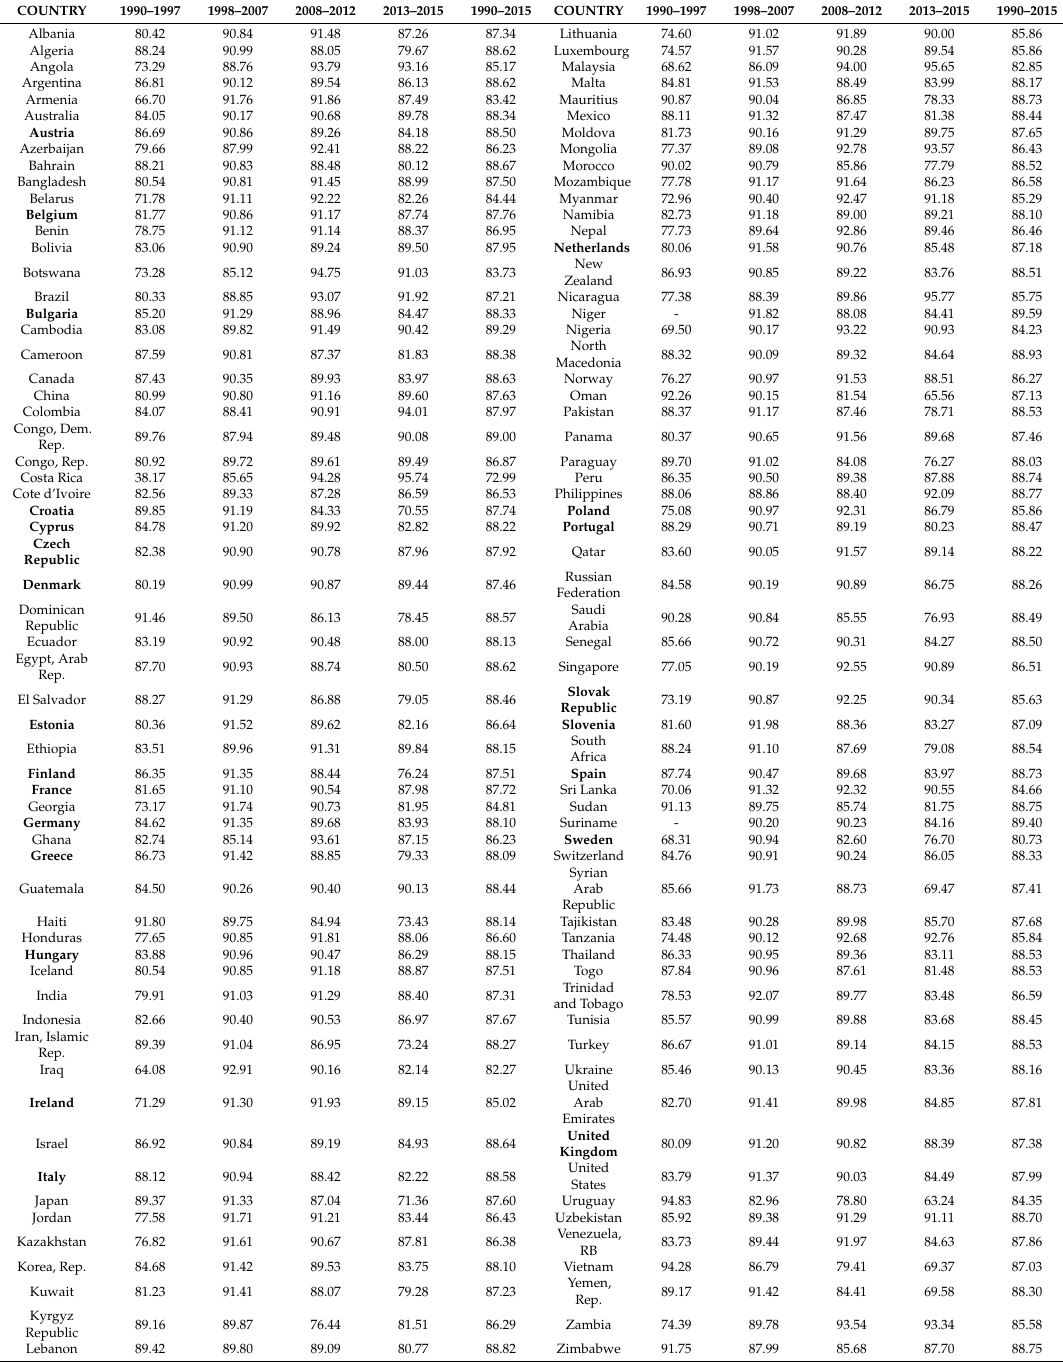
Table 3. Average GHG emission e ffi ciency